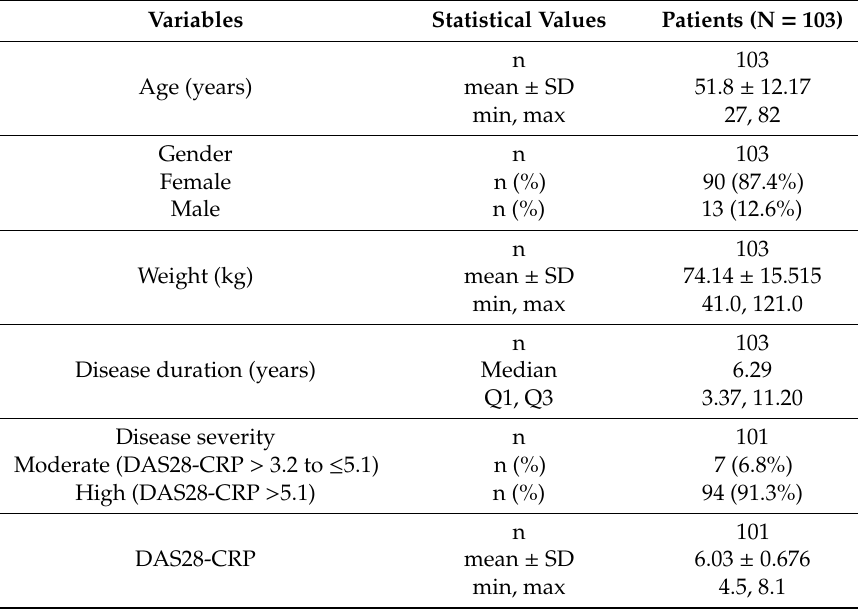
Table 2. Demographic and clinical characteristics of the